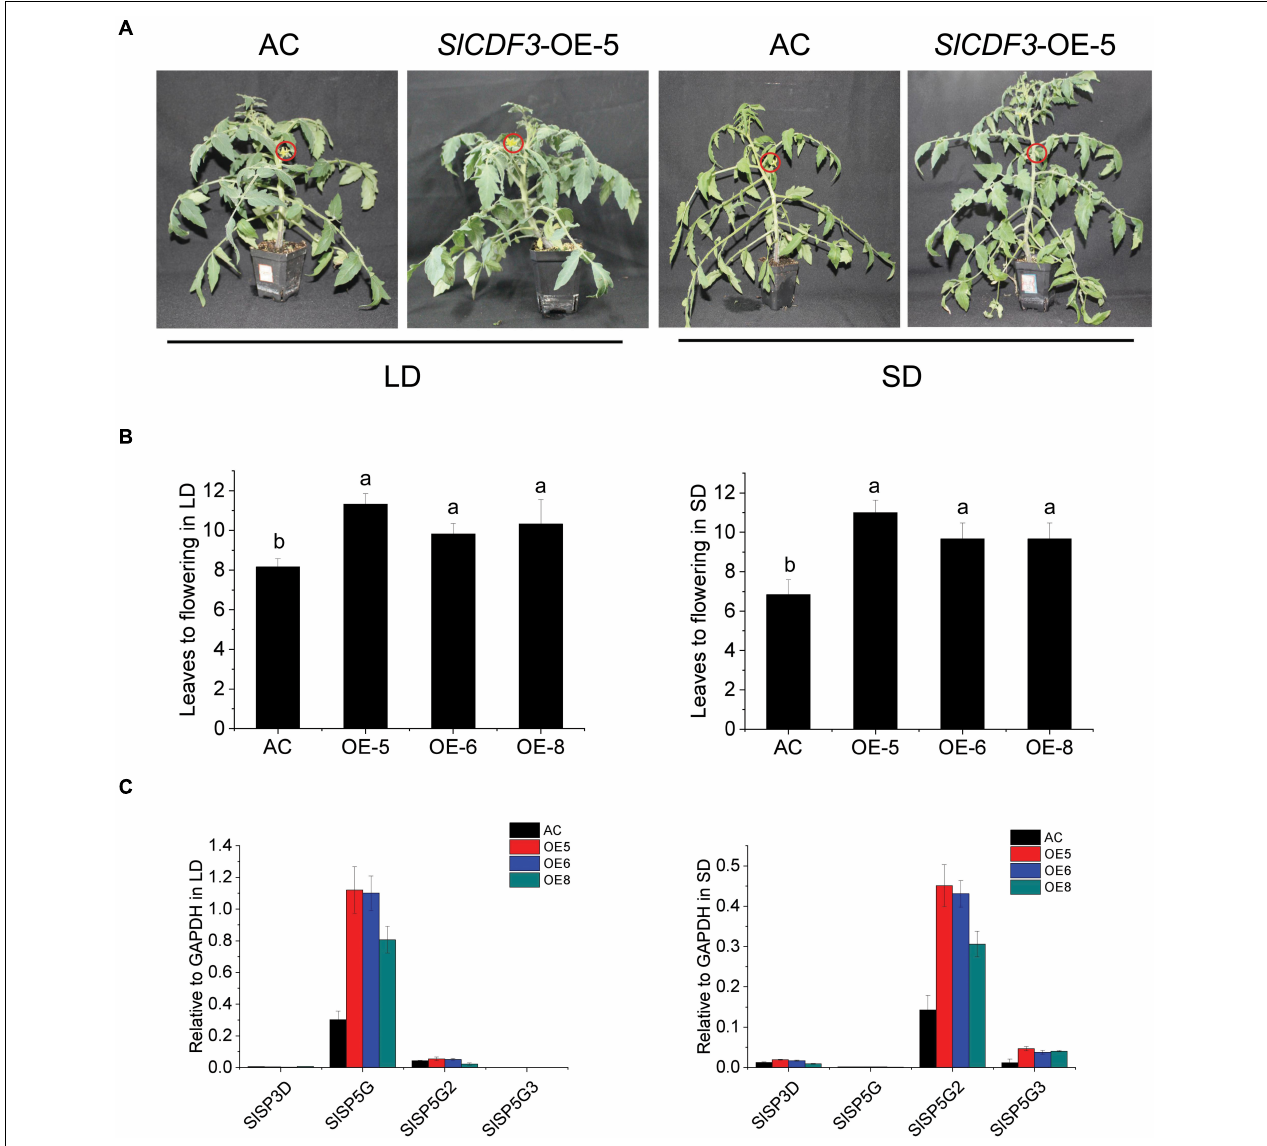
FIGURE 4 | SlCDF3 delayed flowering by regulating different FT-like genes in long-day (LD) and short-day (SD) conditions. (A) Flowering phenotypes of SlCDF3 -overexpressing tomato plants under LD or SD conditions. The red circles indicate flowers. (B) Flowering time of SlCDF3- overexpressing tomato plants represented by leave number under LD or SD conditions. Vertical bars on the lines represent the SE ( n = 6). (C) The transcription levels of tomato FT-like genes in SlCDF3 -overexpressing tomato plants under LD and SD conditions. Three technical replicates were performed for each extract, vertical bars on the lines represent the SE ( n =